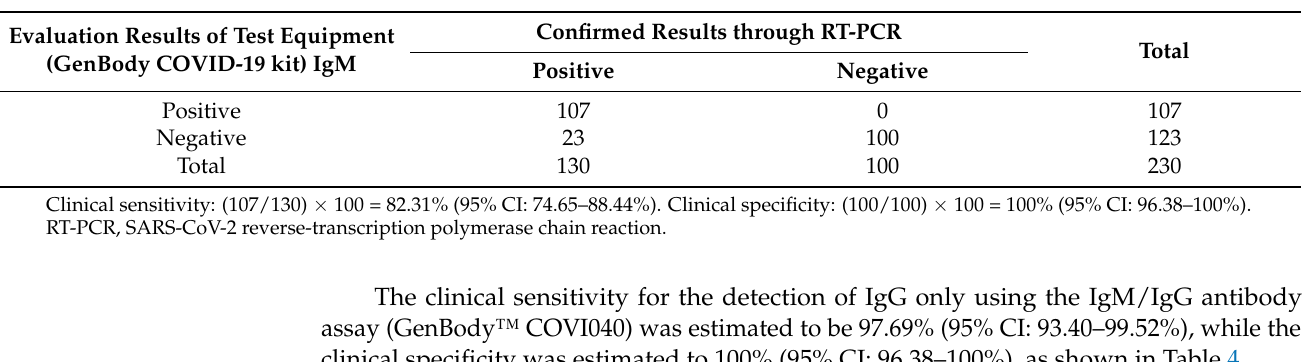
Table 3. IgM antibody test results using the GenBody™ COVI040 assay.